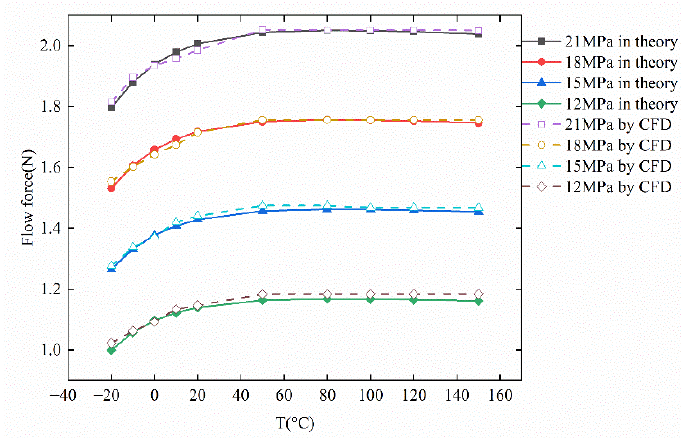
Figure 16. The effect of temperature and inlet pressure on flow force.